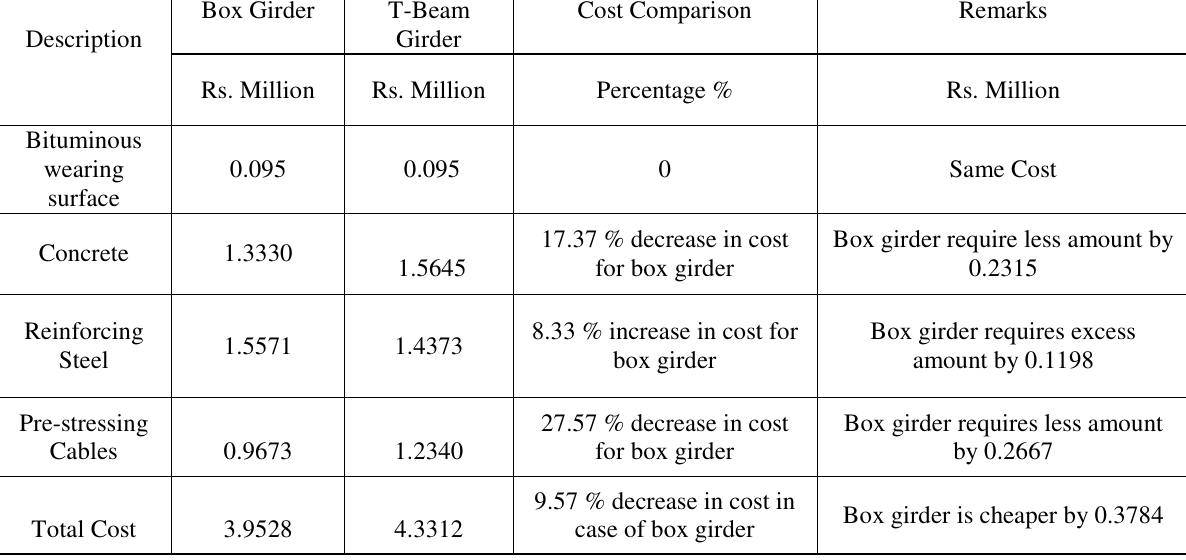
TABLE 9. COMPARISON OF COST FOR BOX AND T BEAM GIRDER